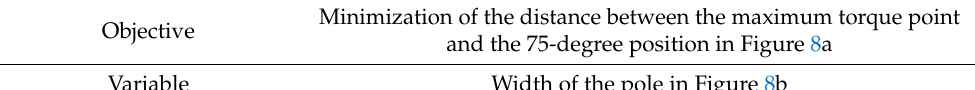
Table 2. The details of the optimization methods.